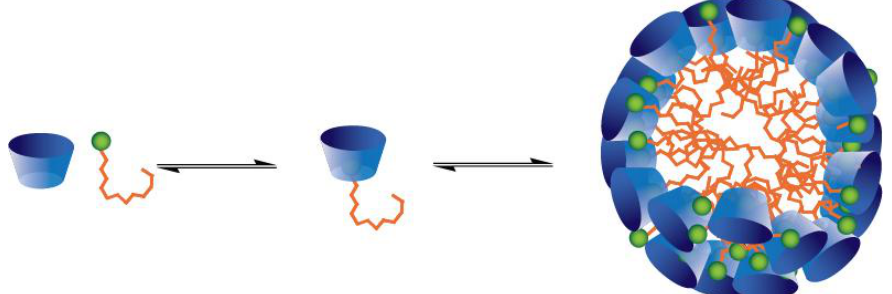
Figure 10. Promoted aggregation of alkyltrimethylammonium surfactants through the formation of host-guest complexes with calix[6]arene 4a (Reprinted with permission from ref. [66]. Copyright 2012, American Chemical Society).